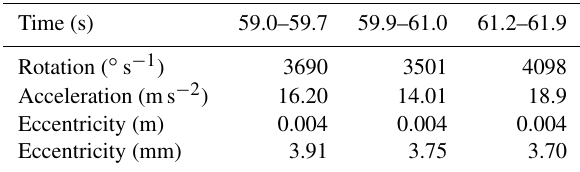
Table 1. Mean values of absolute rotational and acceleration data for calculating